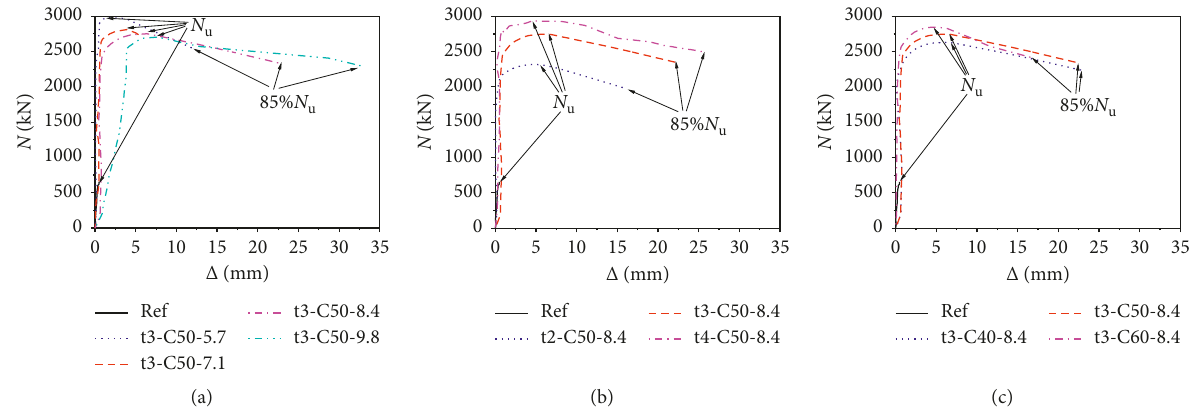
Figure 4: Axial load-lateral deflection response. (a) L / D ratio. (b) D/t ratio. (c) SCC